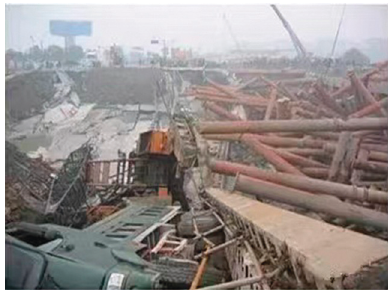
Figure 1: Foundation pit